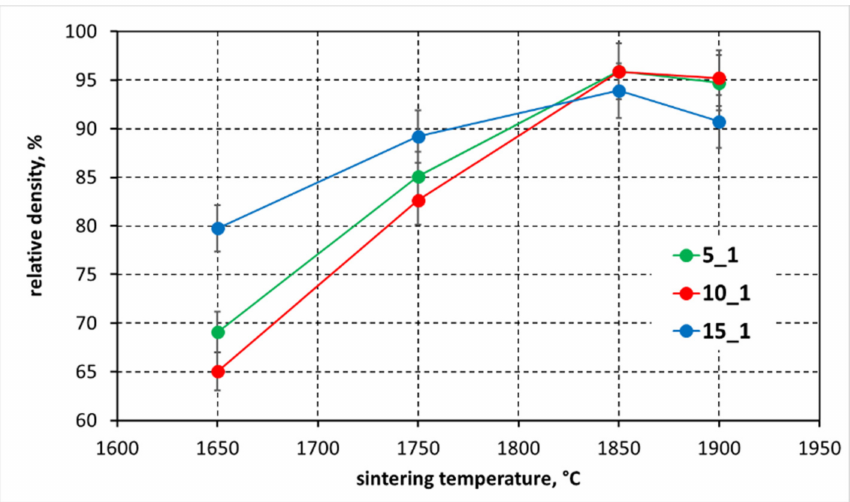
Figure 5. Results of sinters relative density measurements as a function of reaction sintering tempera- ture and initial composition of samples. The 5_1, 10_1 and 15_1 descriptions in the graph refer to the B to C molar ratios used in the reaction mixtures which are B:C = 5:1, 10:1 and 15:1 respectively.